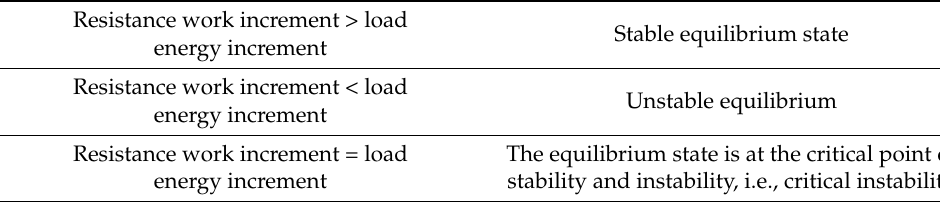
Table 4. Stability conditions of the equilibrium state of the train system.